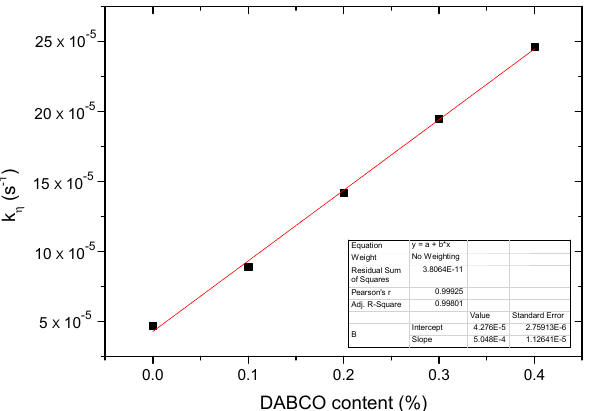
Figure 7. Fitting chart between k η ( T ) and mass fraction of the catalyst DABCO.